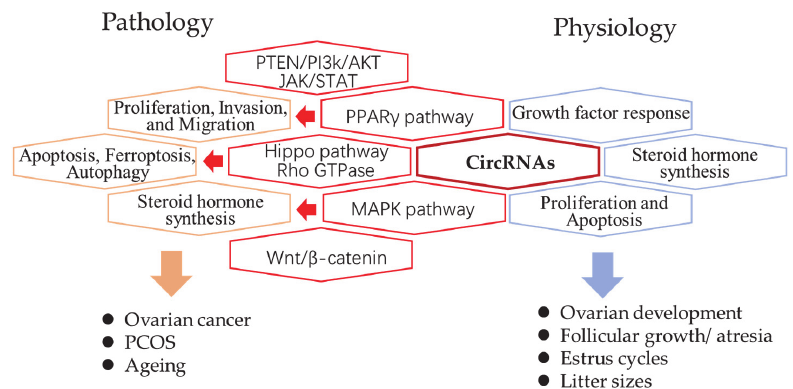
Figure 1. The summary of circRNAs related pathways in pathology and physiology processes of the mammalian ovary. The revealed circRNA ‐ related signaling pathways (red hexagon) and their re ‐ mammalian ovary. The revealed circRNA-related signaling pathways (red hexagon) and their related lated biological processes in pathology (orange hexagon) and physiology (blue hexagon). biological processes in pathology (orange hexagon) and physiology (blue